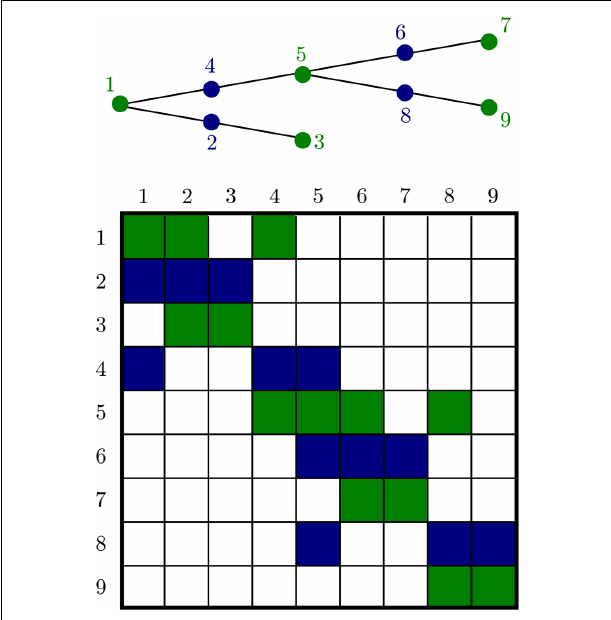
FIGURE 5 | A branched geometry (top) and the structure of the corresponding tree matrix (bottom). Nonzero matrix entries are colored either green or blue depending on the color of the node corresponding to the row. The green nodes at the ends of each segment are algebraic conservation nodes and so the corresponding green rows each sum to 0. The matrix need not be symmetric; a ij is not in general equal to a ji because the entries depend on the volume of compartments i and j ,